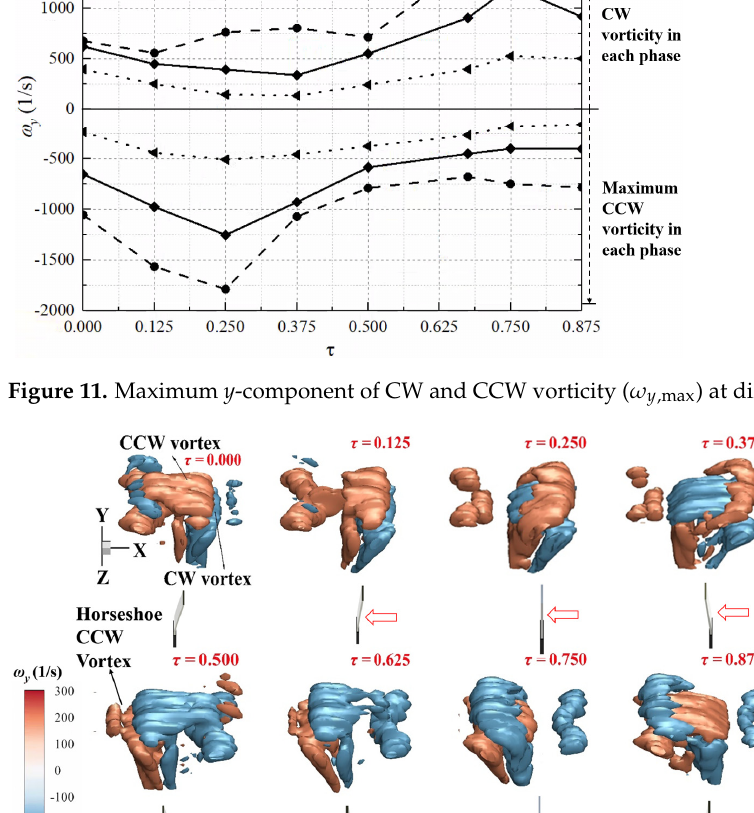
Figure 11. Maximum y -component of CW and CCW vorticity ( ω y , max ) at different phases.